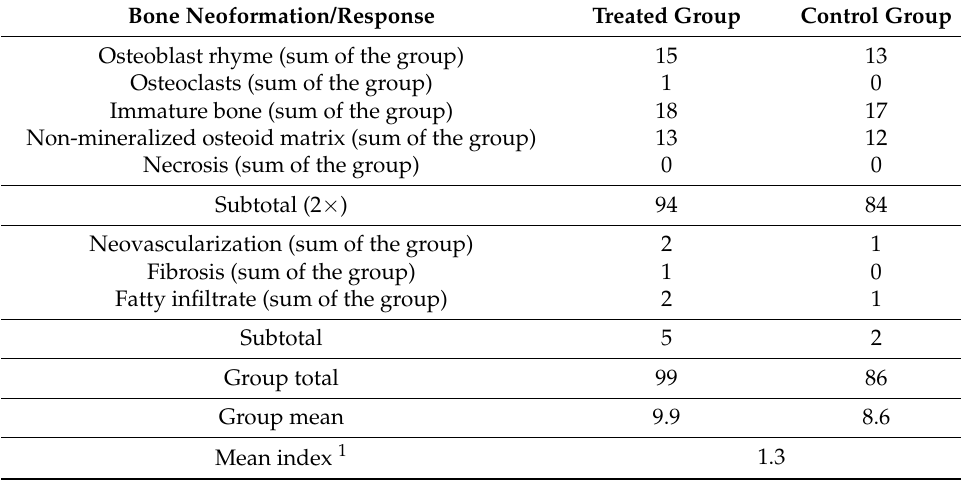
Table 4. Histological indices to evaluate tissue reaction. Bone Neoformation/Response Treated Group Control Group Osteoblast rhyme (sum of the group) 15 13 Osteoclasts (sum of the group) 1 0 Immature bone (sum of the group) 18 17 Non-mineralized osteoid matrix (sum of the group) 13 12 Necrosis (sum of the group) 0 0 Subtotal (2 × ) 94 84 Neovascularization (sum of the group) 2 1 Fibrosis (sum of the group) 1 0 Fatty infiltrate (sum of the group) 2 1 Subtotal 5 2 Group total 99 86 Group mean 9.9 8.6 Mean index 1